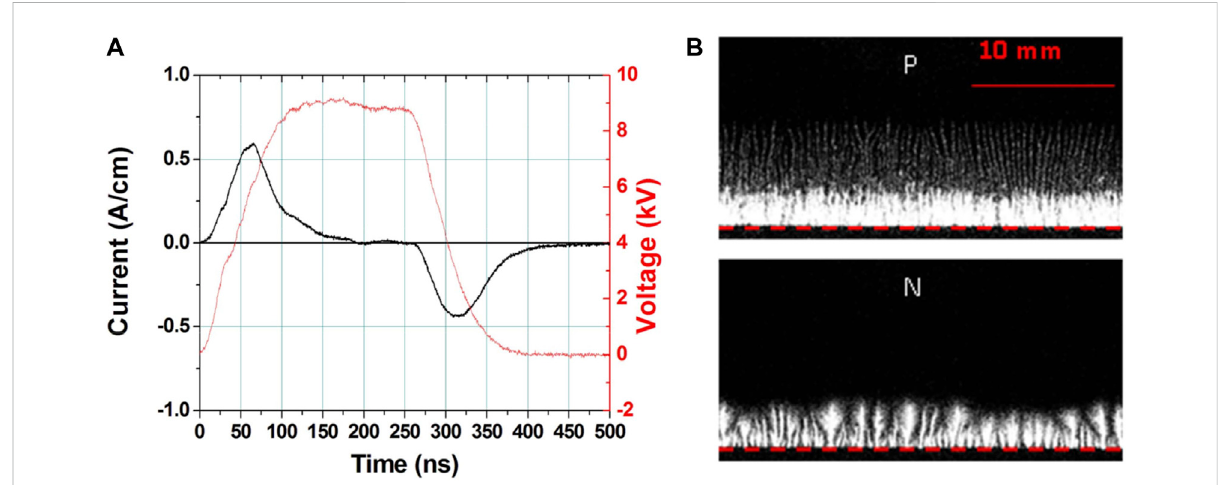
FIGURE 3 (A) Waveformoftheappliedhighvoltageandtheassociateddischargecurrent. (B) TopICCDviewsofthepositive( p )andnegative(N)discharge. Red dotted line: active electrode edge. Figures taken from [46].